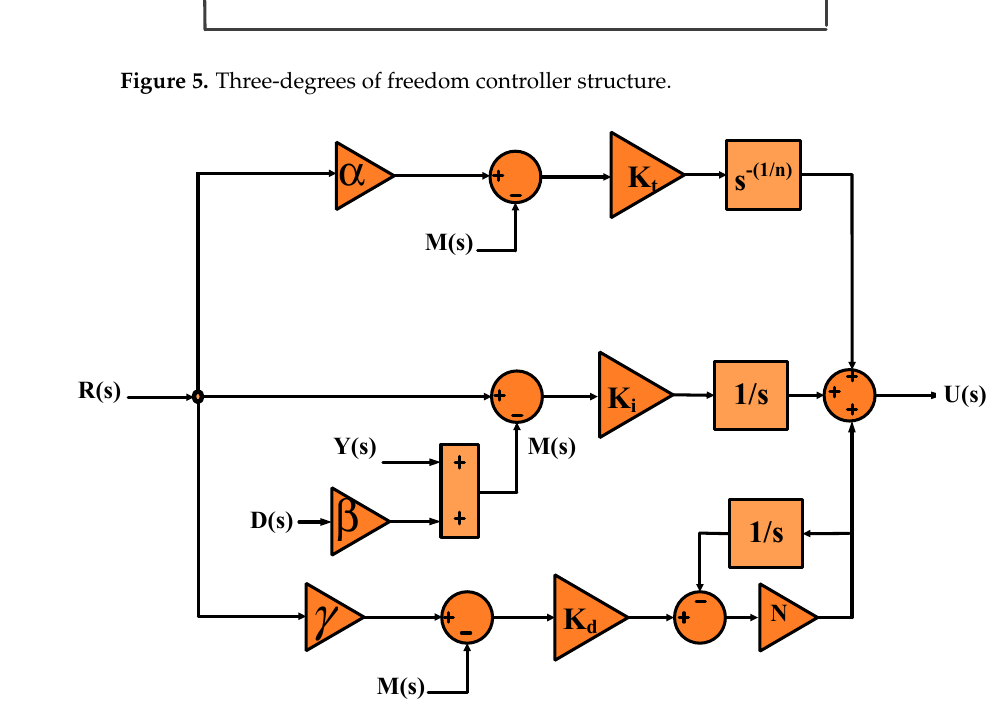
Figure 6. Block diagram of the 3DOF - TID controller.